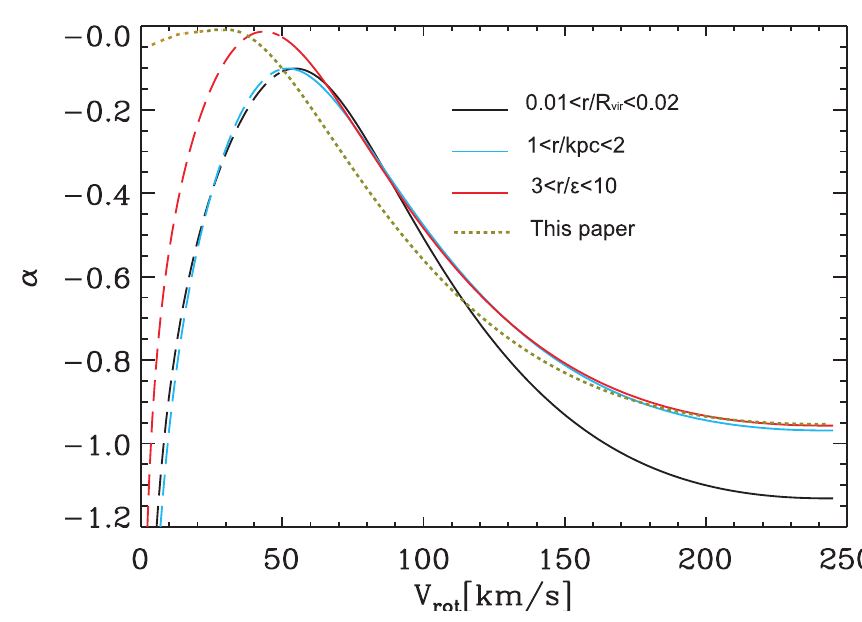
Fig. 4. The (cid:11) vs. v c relation. The three continuous lines represent the result of Di Cintio et al. (2014) in three radial ranges, and the dotted line is our result. The dashed lines in the left side of their maxima are extrapolations of the baryonic TF relation (Dutton et al. 2010) for stellar mass smaller than 10 9 M ⊙